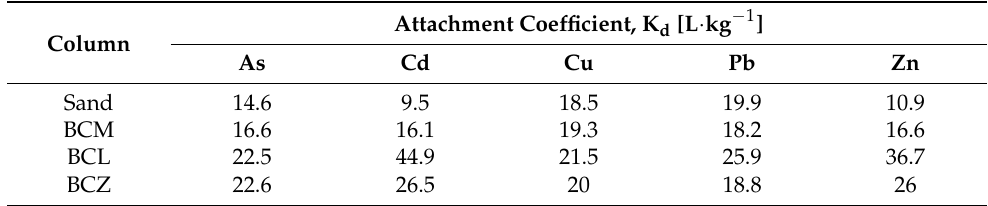
Table 4. Attachment coefficient of metals estimated from HYDRUS 2D for different column media.